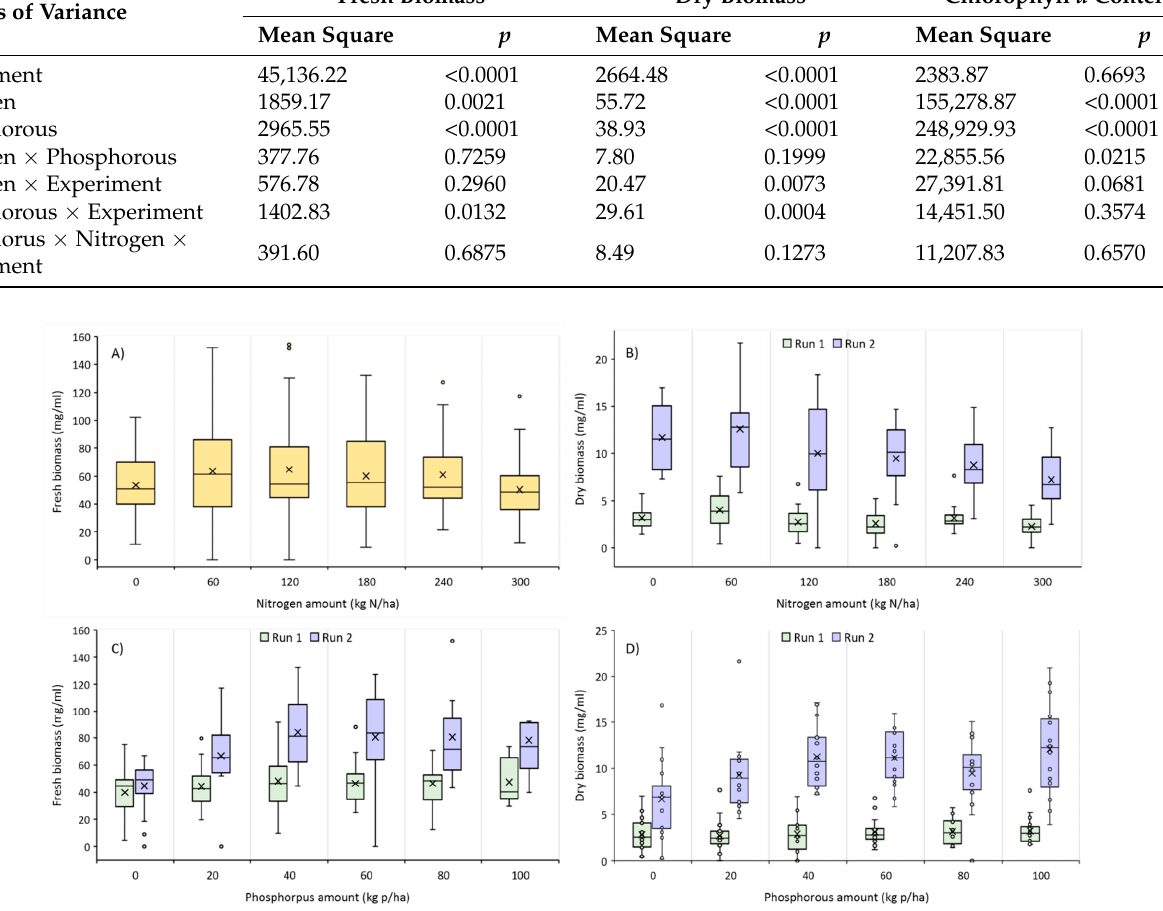
Figure 2. Changes in fresh and dry biomass of algae against various levels of nitrogen ( A,B ) and phosphorous ( C , D ).